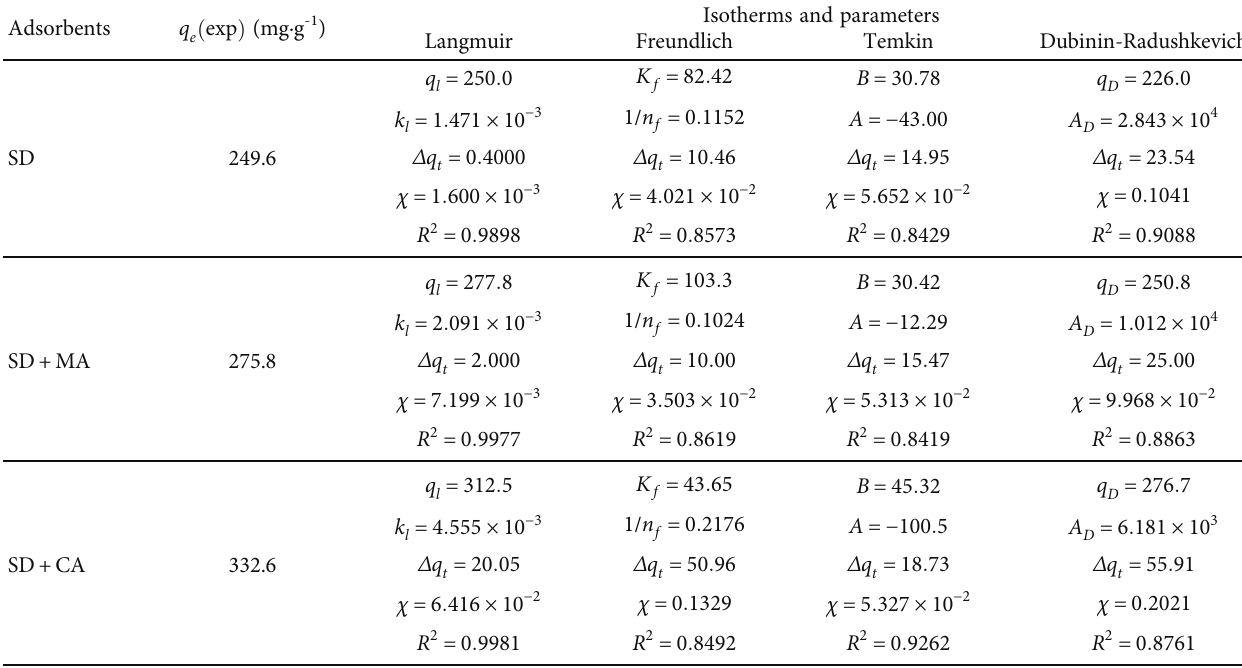
Table 6: Two parameters adsorption isotherm parameters of boron chloride on SD, SD+MA, and SD+CA. exp ð Adsorbents q e